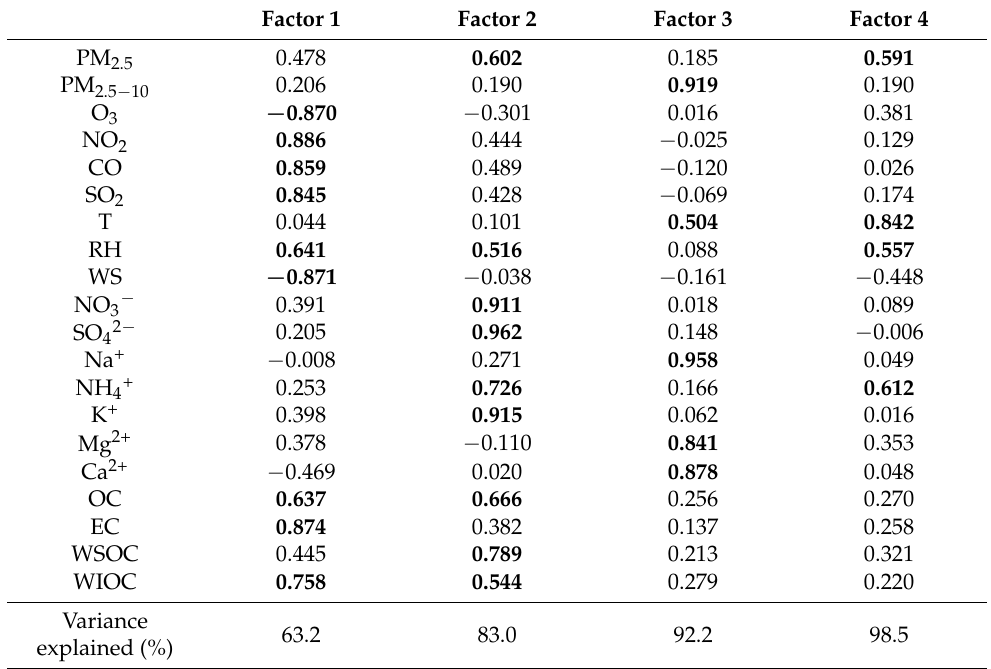
Table 6. Factor loadings in PM 2.5 components with representative gaseous pollutants and meteoro- logical parameters from principal component analysis